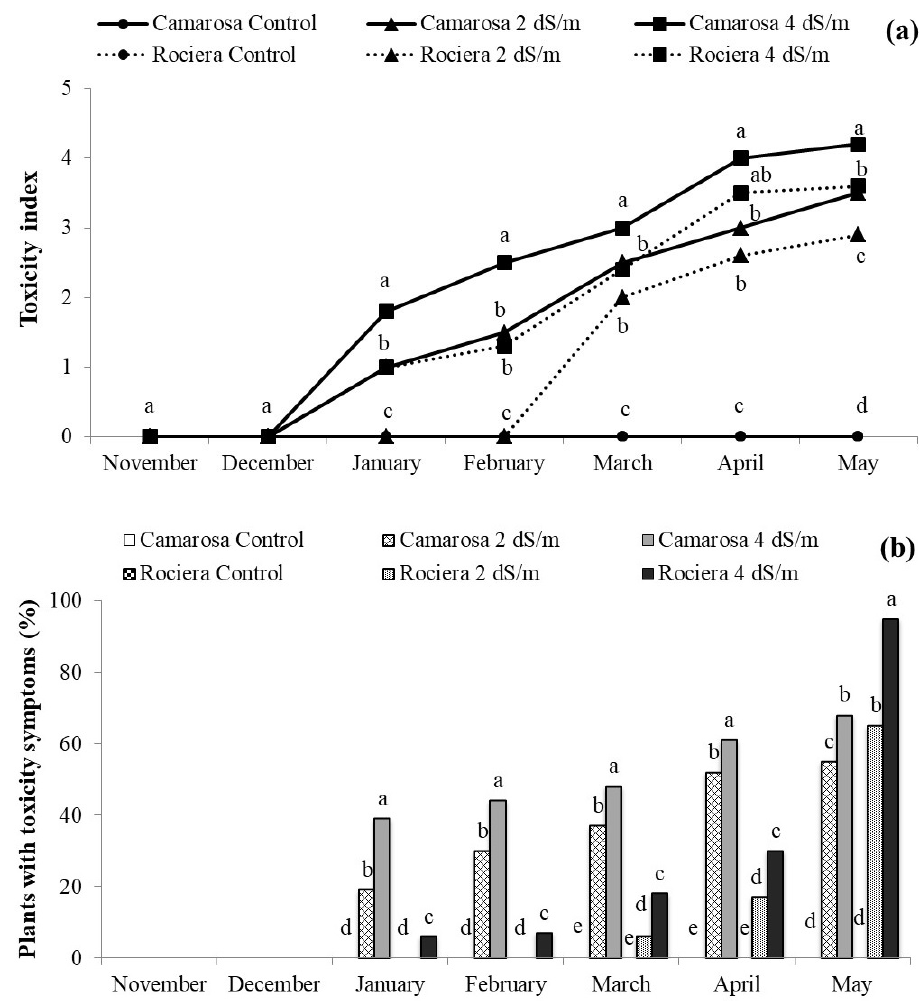
Figure 3. ( a ) Toxicity symptom severity in strawberry plants; ( b ) percentage of strawberry plants that exhibited toxicity symptoms. Different letters within each month indicate significant differences among treatments, according to the Tukey HSD test at a = 0.05.